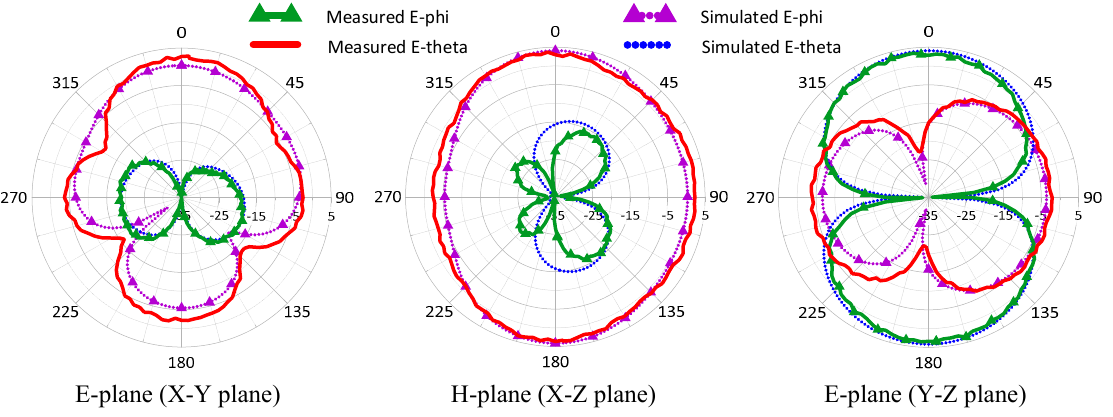
Figure 9. Measured and simulated horizontal polarization mode radiation patterns at 2.45 GHz. Table 3. Performance comparison with reported dual linearly polarized reconfigurable antennas. Ref.